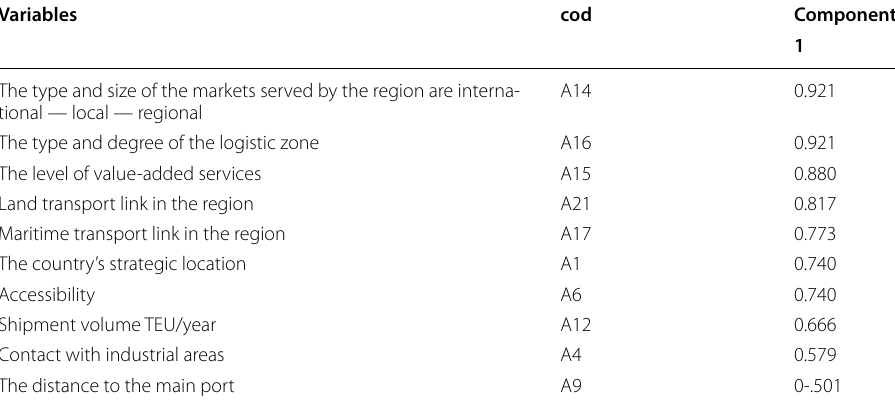
Table 7 Component matrix for site characteristic variables